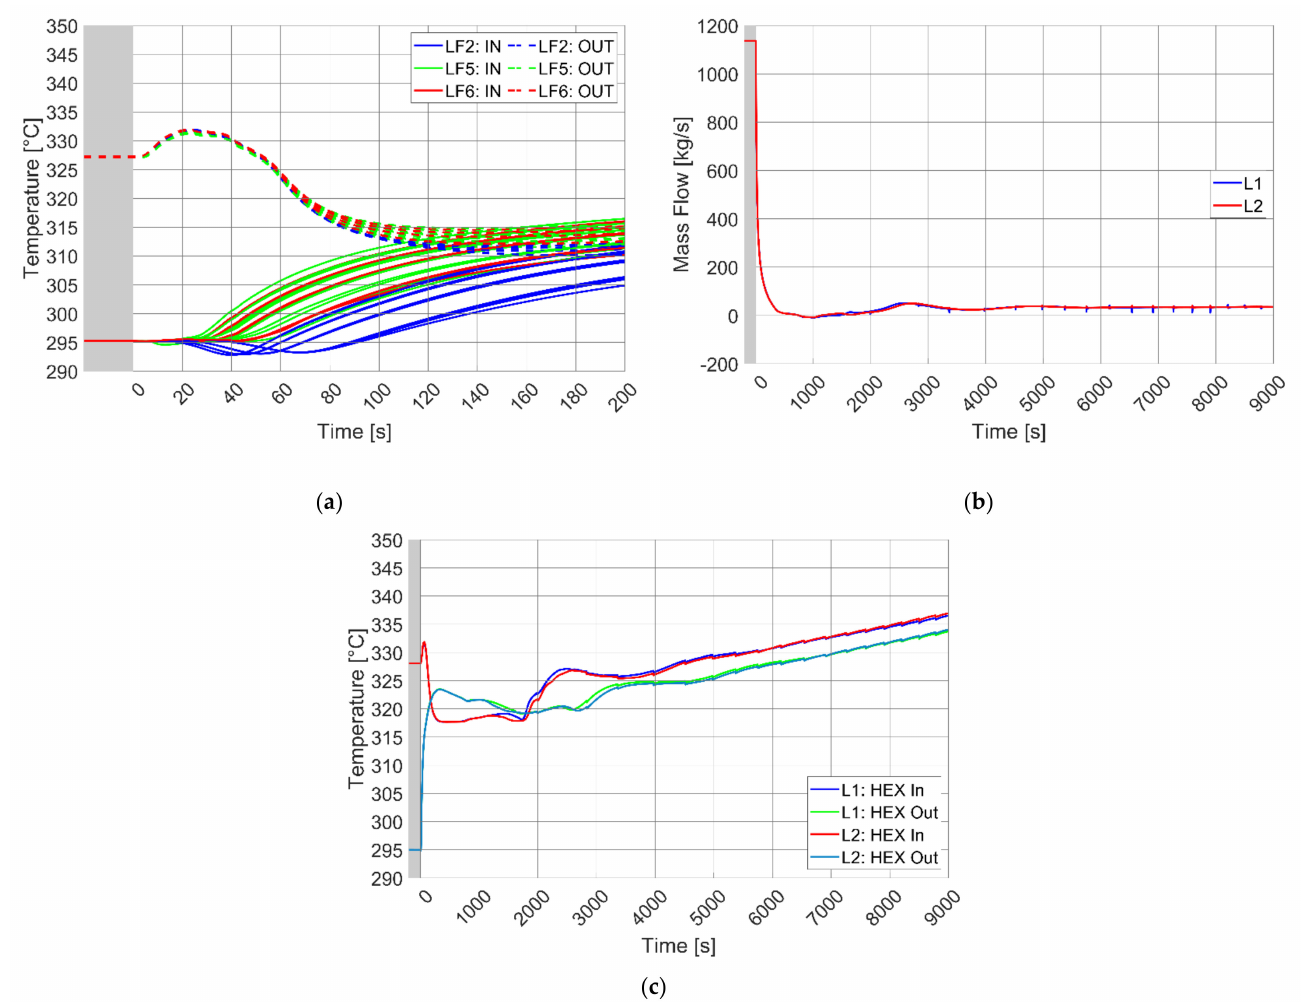
Figure 9. Parameter trends in FW PHTS for LOFA transients characterized by natural circulation (LF2, LF5, LF6): ( a ) FW PHTS water temperatures at BB inlet & outlet (all sectors, early time, COB segment); ( b ) Mass flow elaborated by FW PHTS MCPs (full range, only LF6); ( c ) FW PHTS water temperatures at HEXs inlet & outlet (full range, only